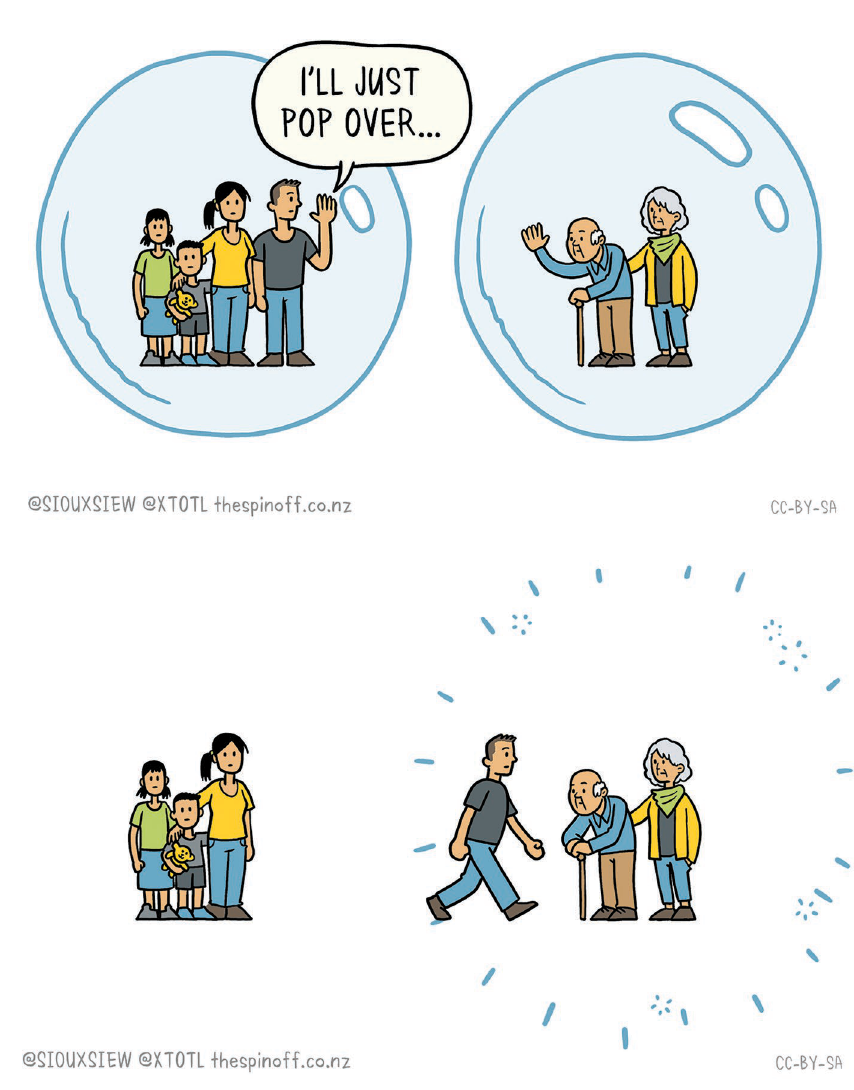
Figure 4. Bubble cartoons used to educate the public about anti-COVID-19 measures.